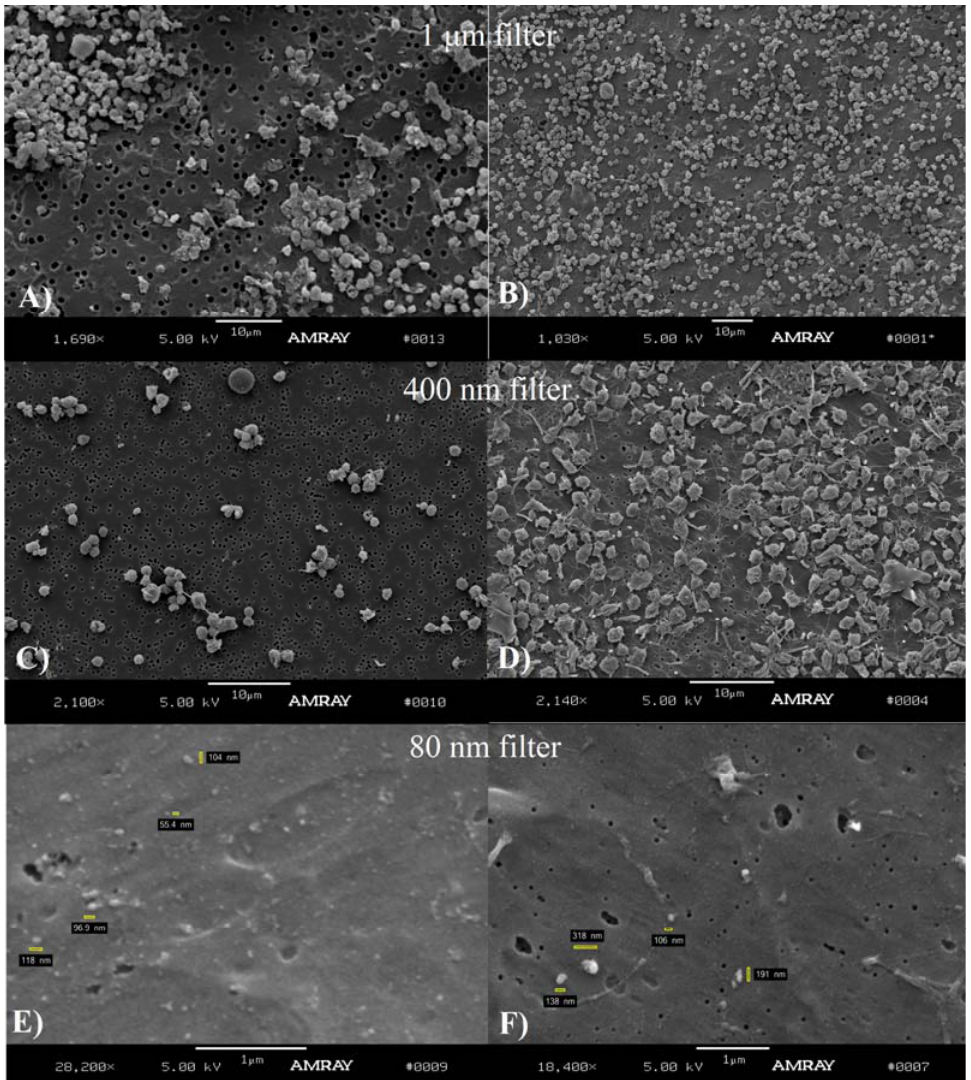
Figure 5. Overall observation of MPs obtained from TC and 2D post-ligation samples without ultracentrifugation (MPS-NOULTRA, as described in Figure 1B). ( A and B ) MPs and platelets deposited on a 1 μ m filter. The eluents of the same suspensions were filtered using a 400 nm filter ( C for TC, D for 2D) and an 80 nm filter E (TC) and F (2D). While a quantitative estimation cannot be done, the results suggest that the filtration procedures preserve a higher number of MPs, compared with the regular ultracentrifugation procedures shown in Figure 4. The size of the particles retained in the filters are in the range of 100 to 300